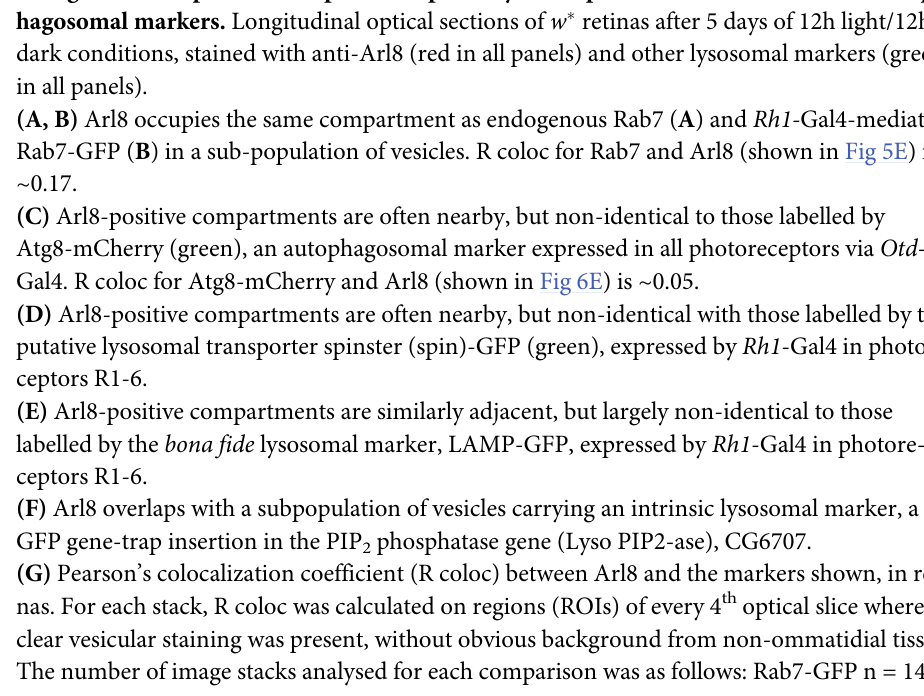
S1 Fig. The Arl8-positive compartment partially overlaps with late endosomal and autop- hagosomal markers. Longitudinal optical sections of w � retinas after 5 days of 12h light/12h dark conditions, stained with anti-Arl8 (red in all panels) and other lysosomal markers (green in all